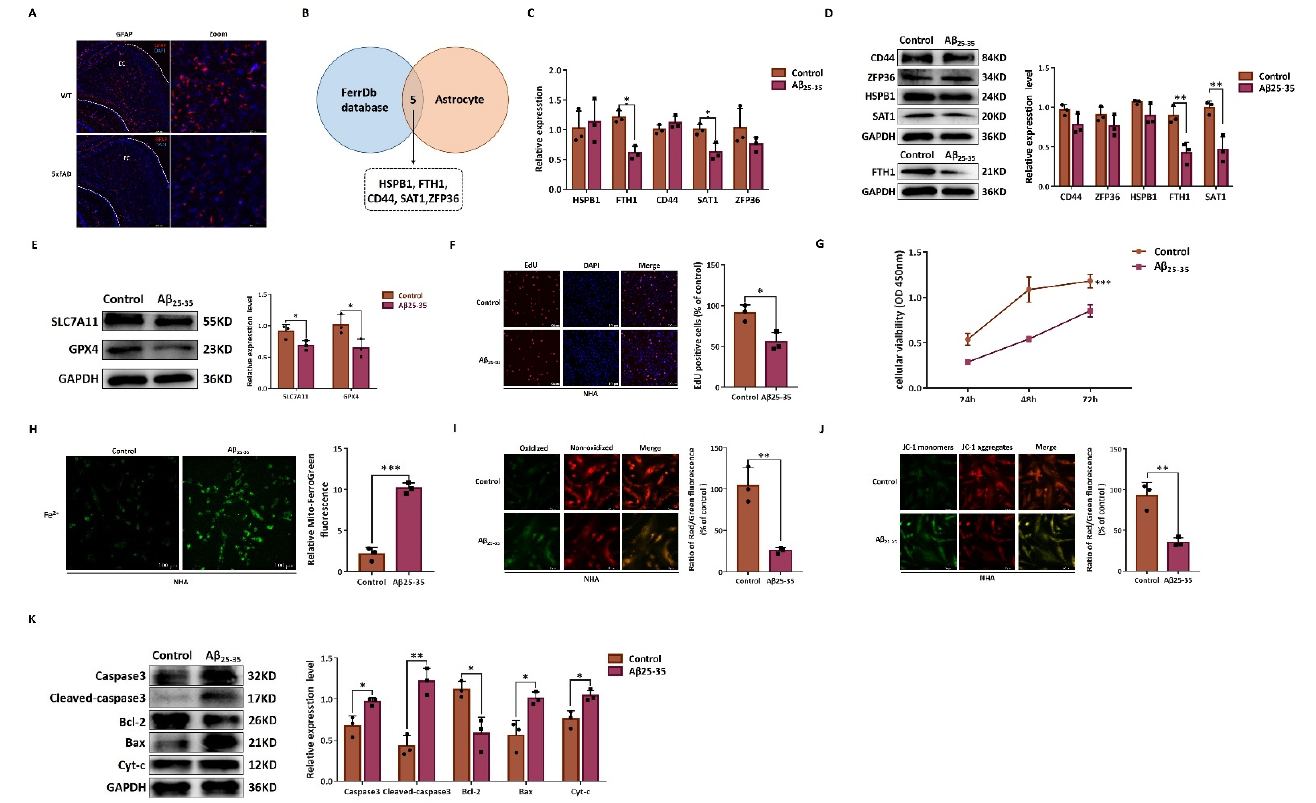
Figure 7. In vitro validation of astrocyte ferroptosis. ( A ) Representative immunofluorescence images of GFAP protein expression in entorhinal cortex region. GFAP-positive astrocytes (red) and DAPI- stained nuclei (blue). ( B ) Venn diagram to interact DEGs in astrocytes with genes related to ferroptosis in FerrDb. ( C ) Expression of HSPB1, FTH1, CD44, SAT1, and ZFP36 by qRT-PCR. ( D ) Expression of HSPB1, FTH1, CD44, SAT1, and ZFP36 by Western blot. ( E ) Expression of SLC7A11 and GPX4 by Western blot. ( F ) Cell proliferation by EdU assay. ( G ) Cell viability by CCK-8 assay. ( H ) Representative image Mito-FerroGreen staining of Fe 2+ . ( I ) Cellular lipid ROS level by C11-BODIPY581/591 dye. Green fluorescence represents oxidized form; red fluorescence represents non-oxidized form. ( J ) Mitochondrial membrane potential by JC-1. ( K ) Expression of Caspase-3, Cleaved-caspase3, Bcl-2, Bax, and Cyt-c by Western blot. Red, JC-1 aggregates; green, JC-1 monomer. WT: wild type. FAD: familial Alzheimer’s disease. EC: entorhinal cortex. EdU: 5-ethynyl-20-deoxyuridine. DAPI: 4 (cid:48) ,6-diamidine-2 (cid:48) -phenylindole dihydrochloride. NHA: normal human astrocytic cells. * p <